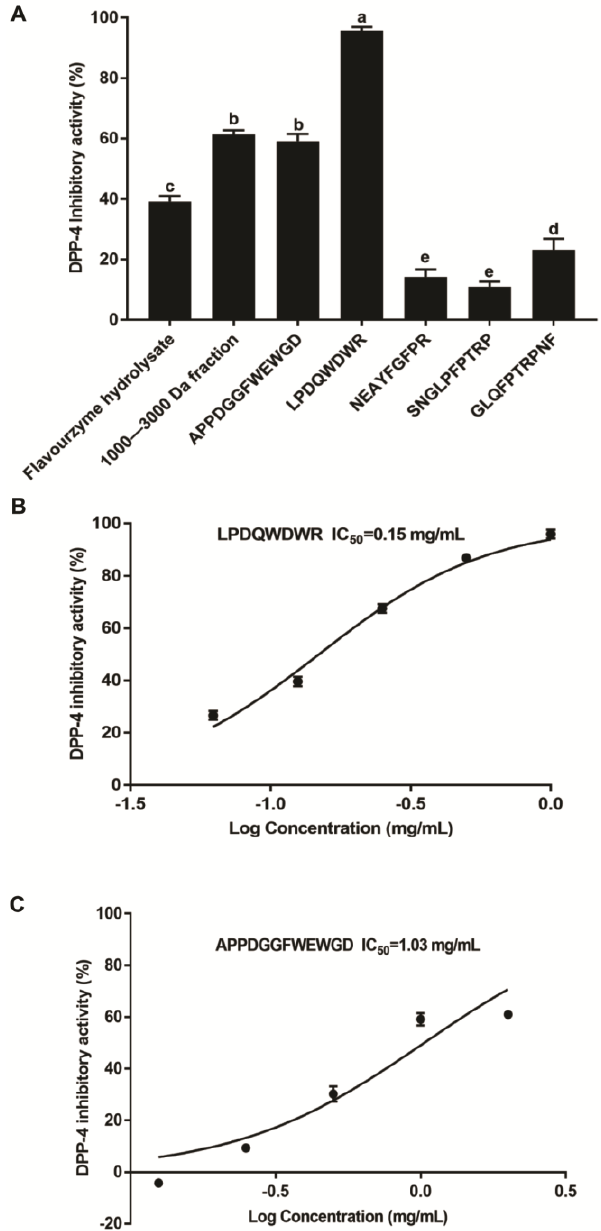
Figure 4. The inhibitory effect of the synthesized peptides on dipeptidyl peptidase-4 (DPP-4) activity. ( A ) Inhibitory effect of the synthesized peptides at a final concentration of 1 mg/mL on DPP-4 activity. ( B ) DPP-4 IC 50 value of peptide LPDQWDWR against DPP-4 activity. ( C ) IC 50 value of peptide APPDGGFWEWGD against DPP-4 activity. Data are shown as the mean ± SD ( n = 3), and different letters mean significant difference ( p <